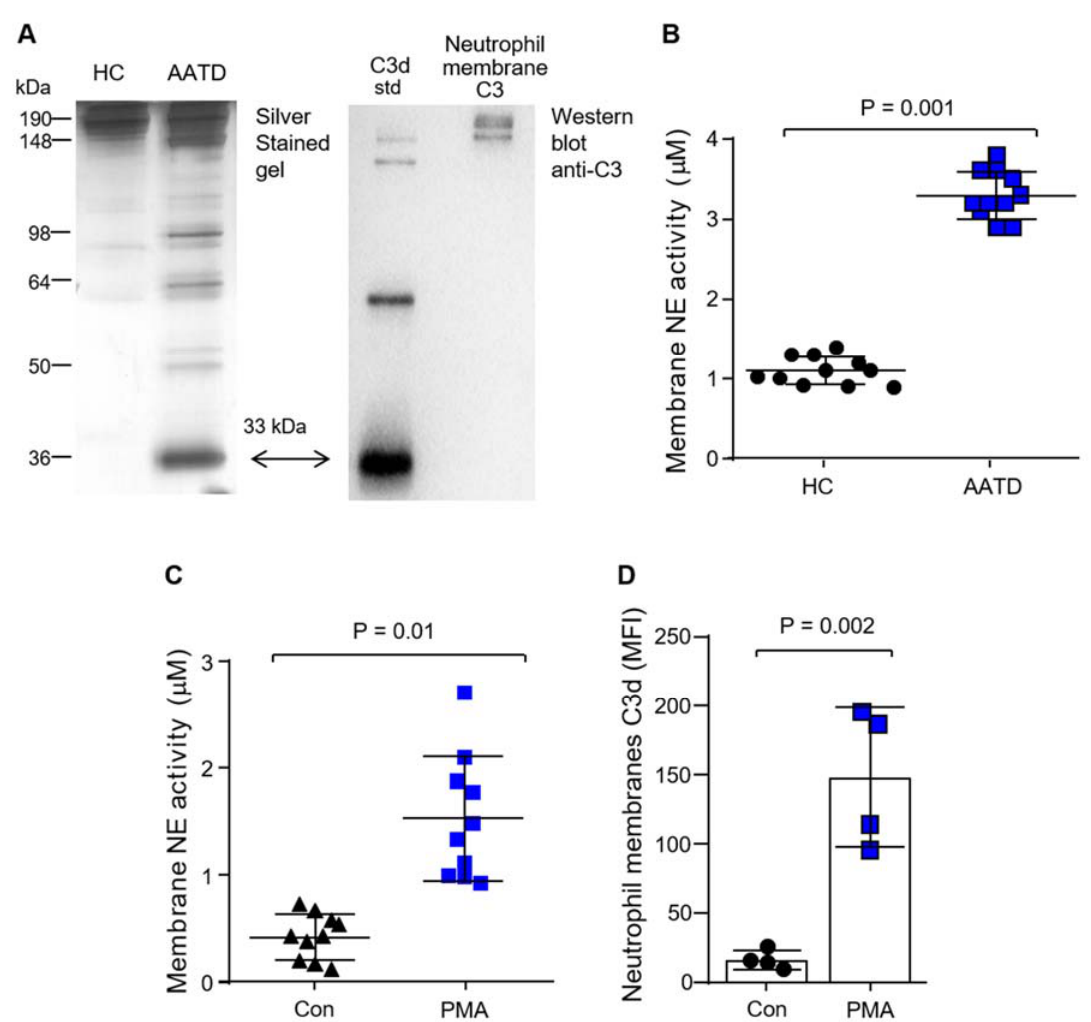
Figure 2. Neutrophil elastase-mediated C3d production. ( A ) Plasma of HC or AATD patients was incubated with 10 µ g/mL NE for 1 h at 37 ◦ C. Left panel: silver stain of a 12.5% ( w/v ) non-reducing SDS-PAGE gel demonstrating C3 in HC plasma. The digestion products of C3 proteolysis are observed in AATD plasma. A number of proteolytic bands are seen, including at 33 kDa band corresponding to the C3d fragment. Right hand panel: Western blot of HC neutrophil membrane fractions on a 12.5% ( w/v ) non-reducing SDS-PAGE gel using rabbit polyclonal anti-C3 antibody. A 186 kDa band corresponding to C3 is visible. C3d protein standard (33 kDa) was used as a control. The silver-stained gel and Western blot are representative images of n = 3 independent experiments. ( B ) Membrane-bound NE activity was measured on HC and AATD neutrophils by FRET analysis. NE activity levels were significantly higher on the membranes of AATD neutrophils ( p = 0.001, n = 11 biological samples, Student’s t -test). ( C ) NE activity was significantly higher on membranes of HC neutrophils following stimulation with PMA for 10 min compared to unstimulated cells (Con) ( p = 0.01, n = 10 biological repeats, Student’s t -test). ( D ) C3d expression on HC neutrophils is significantly increased post PMA stimulation compared to unstimulated (Con) neutrophils ( p = 0.002, n = 4 biological repeats, Student’s t